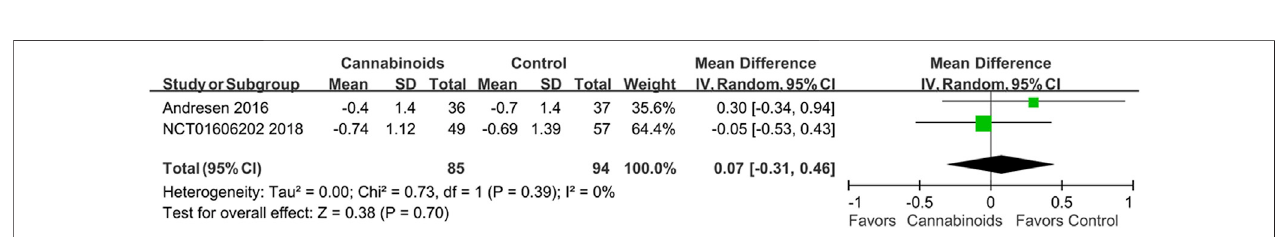
FIGURE 7 | Post hoc analysis comparing cannabinoids to placebo after including only studies reporting NRS as pain scores. Better pain control is shown by the favored side of the plot.